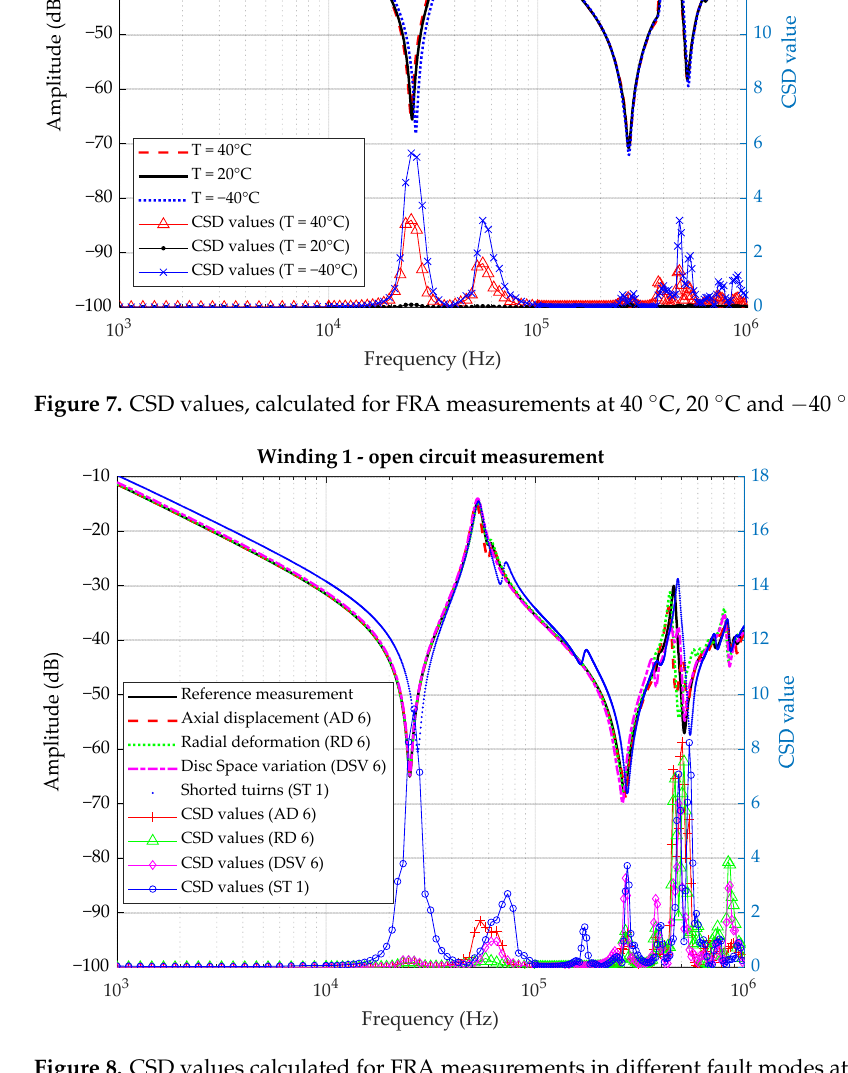
Figure 8. CSD values calculated for FRA measurements in different fault modes at 20 °C.